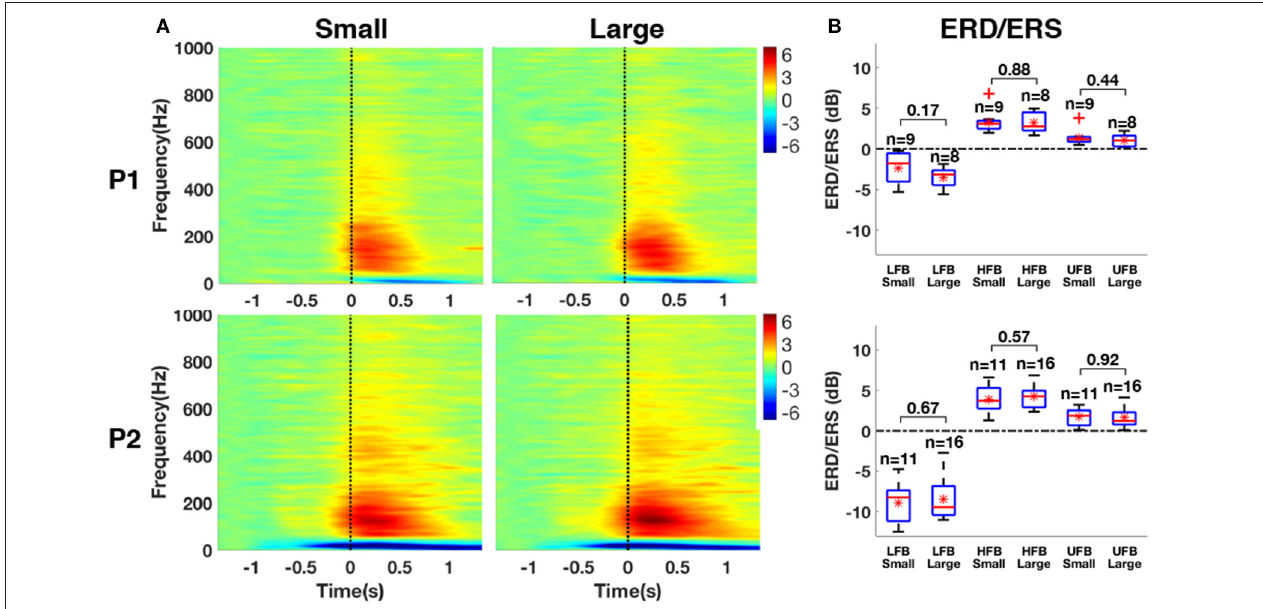
FIGURE 12 | (A) Average time-frequency maps between small and large contact groups with significant ERS in HFB. (B) Box-and-whisker plots of the magnitude of ERD in LFB, ERS in HFB, and ERS in UFB between small and large contact groups. Red asterisk denotes mean value, the red band within the box denotes the median and the outliers are represented by red plus